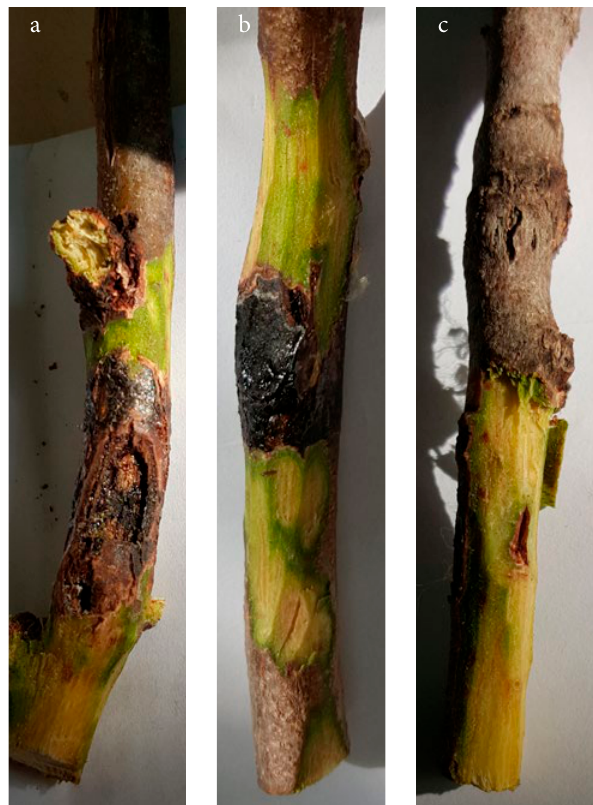
Figure 4. Subcortical dark-brown discolorations spreading from the inoculation points on Grevillea robusta twigs, 3 months after artifi- cial inoculation with Diplodia africana (a), Diplodia seriata (b) and agar plugs not inoculated with a fungus